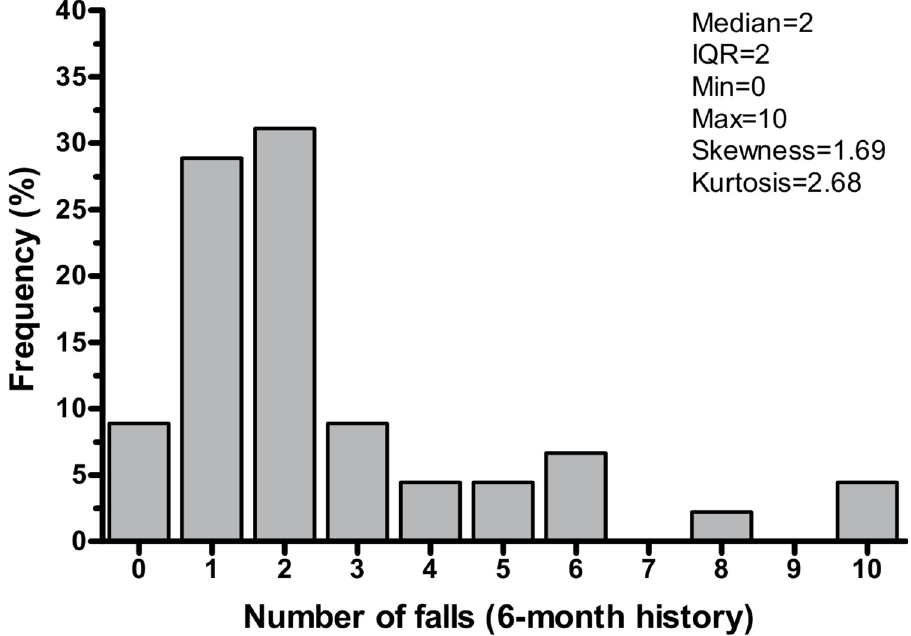
Fig 3. Distribution of number of falls in the previous six months (fall-history). IQR = interquartile